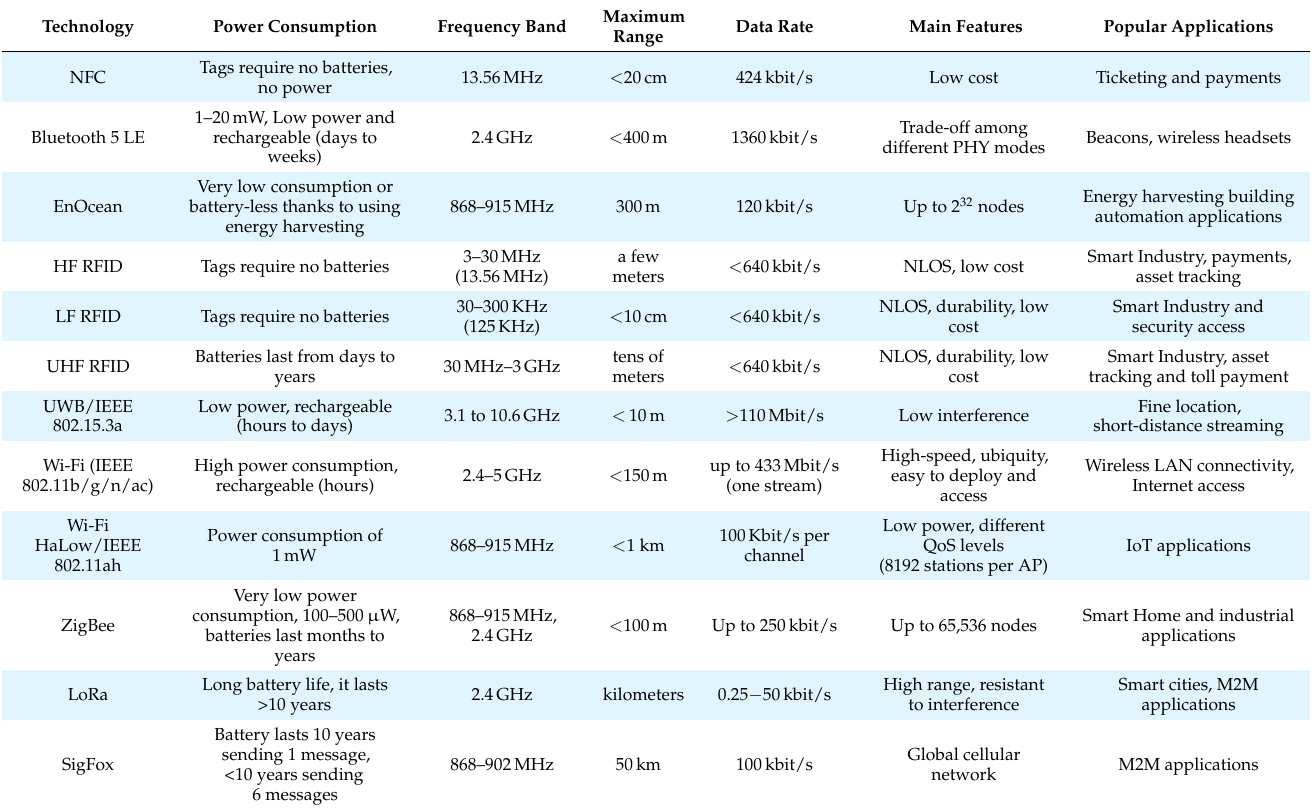
Table 1. Main characteristics of the most relevant communications technologies for G-IoT